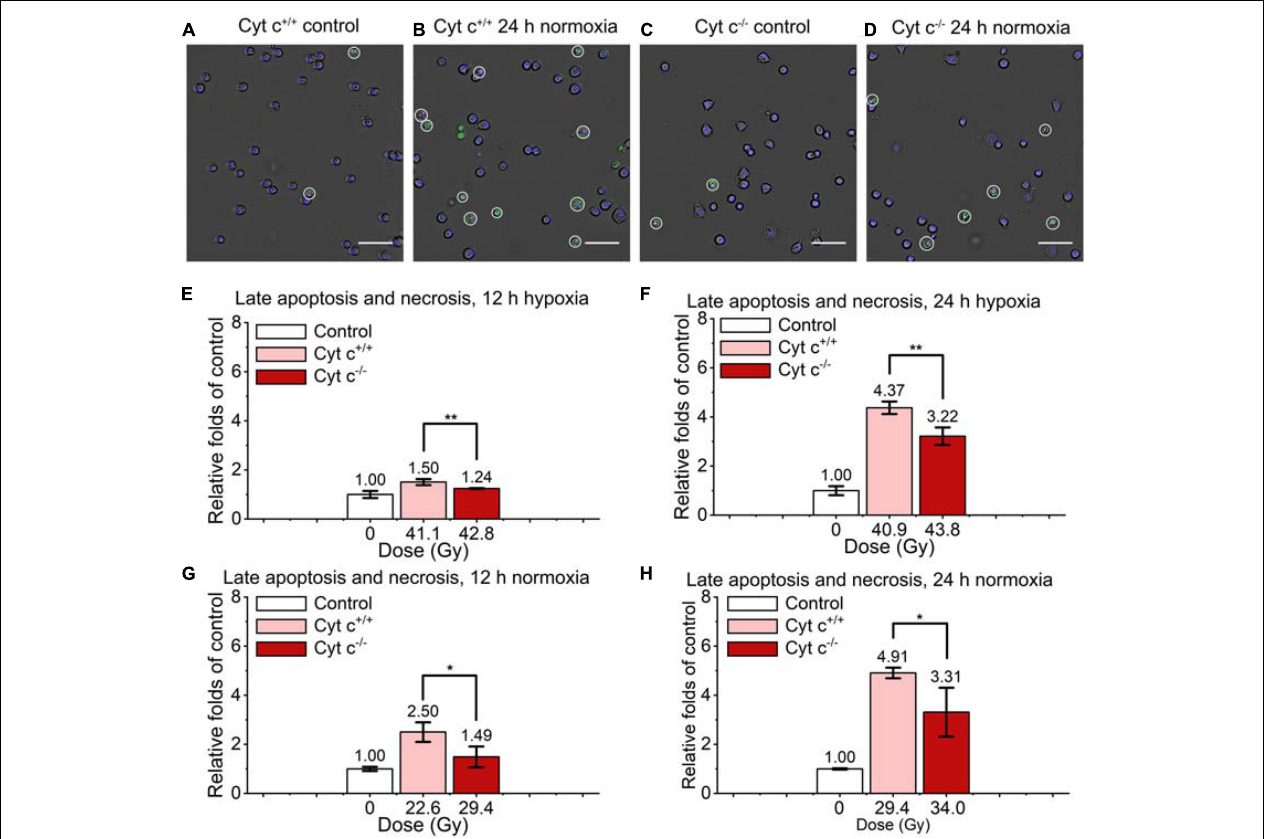
FIGURE 6 | Comparison of late apoptosis and necrosis between irradiated cyt c + / + and cyt c − / − cells after FLASH irradiation. (A–D) Representative images of cyt c + / + control (A) , cyt c + / + irradiated (B) , cyt c − / − control (C) and cyt c − / − irradiated cells (D) at 24 h in normoxic condition. Late apoptotic and necrosis cells were marked with white circles. Scale bars: 100 µ m. (E–H) The relative increasement of late apoptotic and necrosis for irradiated cyt c + / + and cyt c − / − cells at 12 h in hypoxia (E) , 12 h in normoxia (G) , 24 h in hypoxia (F) , and 24 h in normoxia (H)